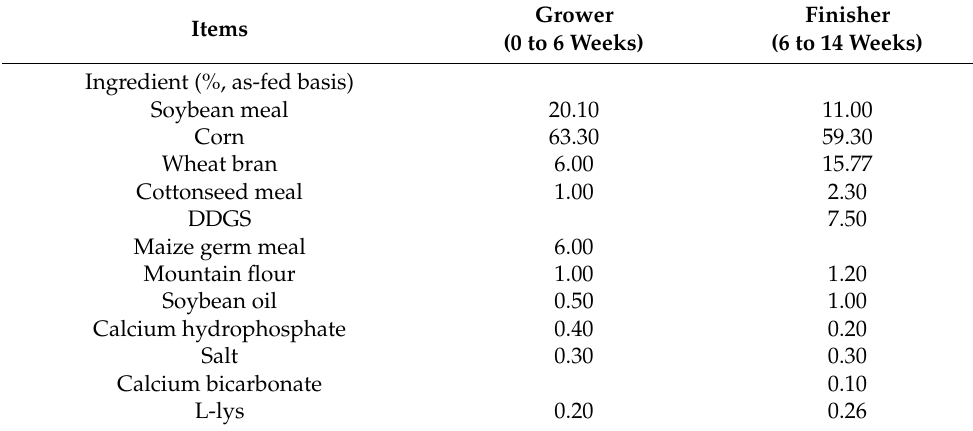
Table 1. Composition and nutrient levels of experimental diets (air-dry